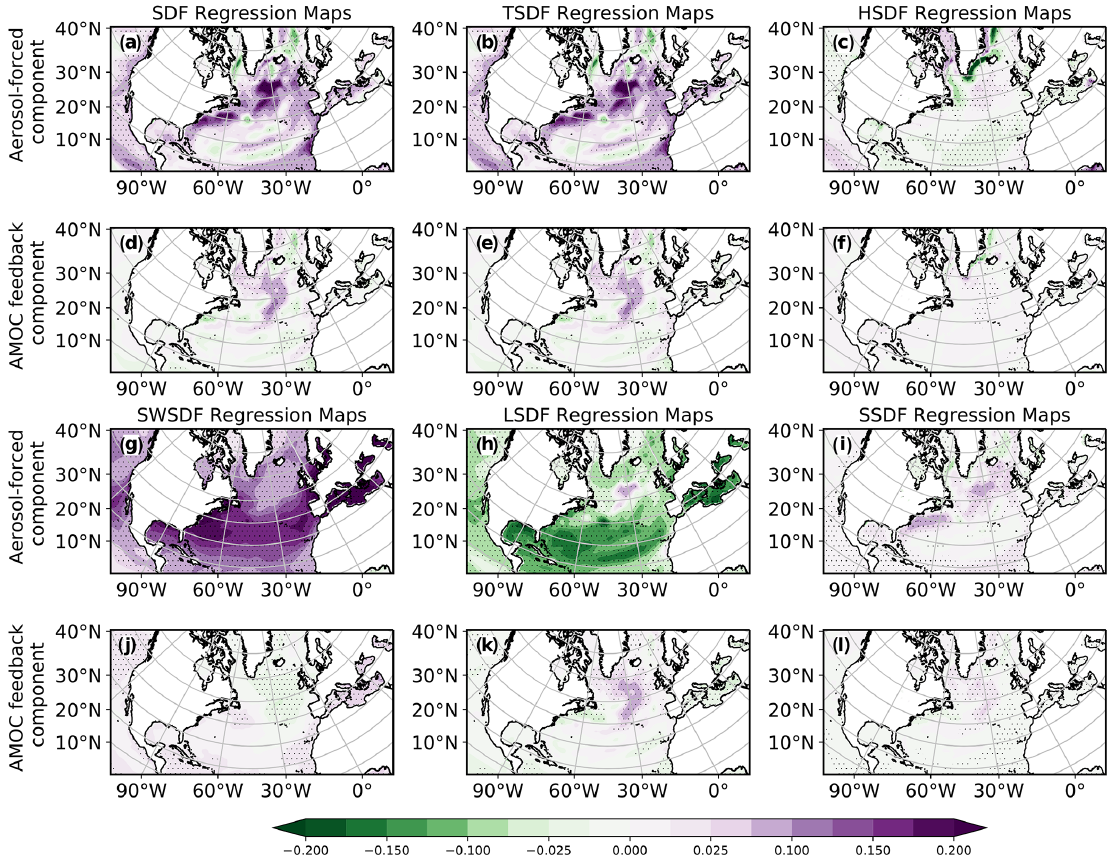
Figure 5. The 1940–2020 ensemble mean annual mean CMIP6 all forcing regression analysis: decomposition of (a, d) surface density flux (SDF); (b, e) thermal component of SDF (TSDF), (c, f) haline component of SDF (HSDF), (g, j) net surface shortwave-radiation-driven SDF (SWSDF), (h, k) latent heat-flux-driven SDF (LSDF), and (i, l) sensible heat-flux-driven SDF (SSDF) into (a–c, g–i) aerosol-forced and (d–f, j–l) AMOC feedback components. The forced response is obtained by regressing the subpolar North Atlantic − 1 · SW time series (a proxy for anthropogenic aerosols) onto each field. The AMOC-related feedback is obtained by removing the variability associated with the forced response, and then regressing the AMOC time series onto this new field. The feedback field is converted to the same units as the aerosol- forced field by multiplying the feedback field by the regression slope between the AMOC and − 1 · SW subpolar North Atlantic time series δ( AMOC ) = 0 . 32Sv ( Wm − 2 ) − 1 , significant at the 95% confidence level. The units for all SDF regression maps are mgm − 2 s − 1 ( Wm − 2 ) − 1 . δ( − 1 · SW ) Symbols denote regression significance at the 95% confidence